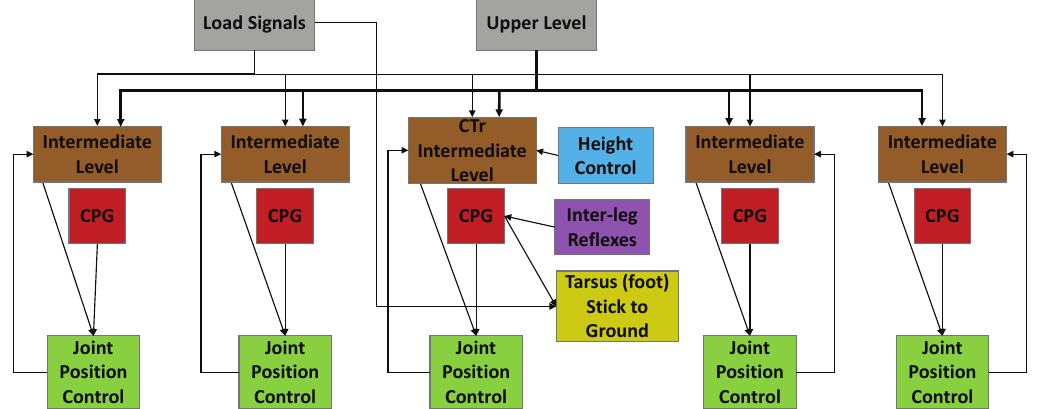
Figure 3. Functional diagram of the synthetic nervous system used for one leg. Each leg consists of five joints. Descending commands from the higher level brain and load signals (gray) affect the intermediate network (brown). Central pattern generators (CPGs, red) generate the rhythmic movement and are present in each joint. The intermediate network and the CPGs establish a commanded position for each joint. Joint controllers (green) take the commanded position and move the joint to that position. Signals from other legs coordinate walking via inter-leg reflexes (purple). Height control networks (blue) are present in each leg. When the leg is loaded and in stance phase, the foot is frozen to the ground (yellow). Note that this is a simple functional diagram; each functional unit consists of dynamics neurons connected to each other via